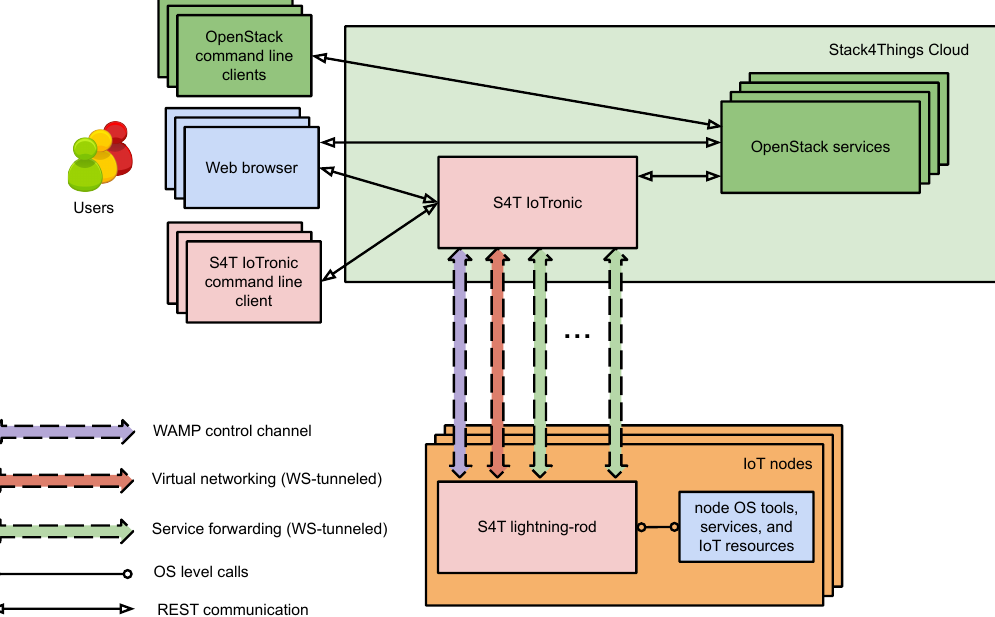
Figure 4. S4T architecture